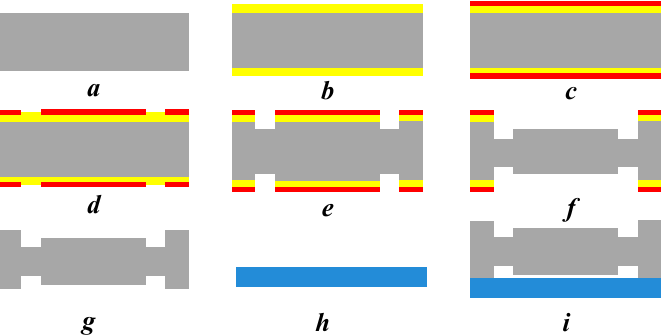
Figure 9. The processing flow of the threshold determination mechanism. ( a ) Preparation of 4-inch silicon wafer; ( b ) oxidation, thermal oxygen to form SiO 2 ; ( c ) homogenizing; ( d ) double-sided lithography, threshold-determination-mechanism graphic selection; ( e ) deep-reactive-ion etching (DRIE)–graphical threshold-determining mechanism by DRIE; ( f ) removal of mask layer of flame-proof slider (photoresist, silicon dioxide), double-sided etching, completion of threshold-determination mechanism and explosion-proof slider processing; ( g ) removal of mask layer. Concentrated deposition of 98% sulfuric acid and hydrogen peroxide in a water bath at 120 °C to remove photoresist and physical deposition of impurities, hydrogen fluoride (HF) to remove SiO 2 mask layer; ( h ) glass preparation; ( i ) anode bonding–glass is bonded to the silicon-based MEMS S&A device. The silicon-based MEMS S&A device was shown in Figure